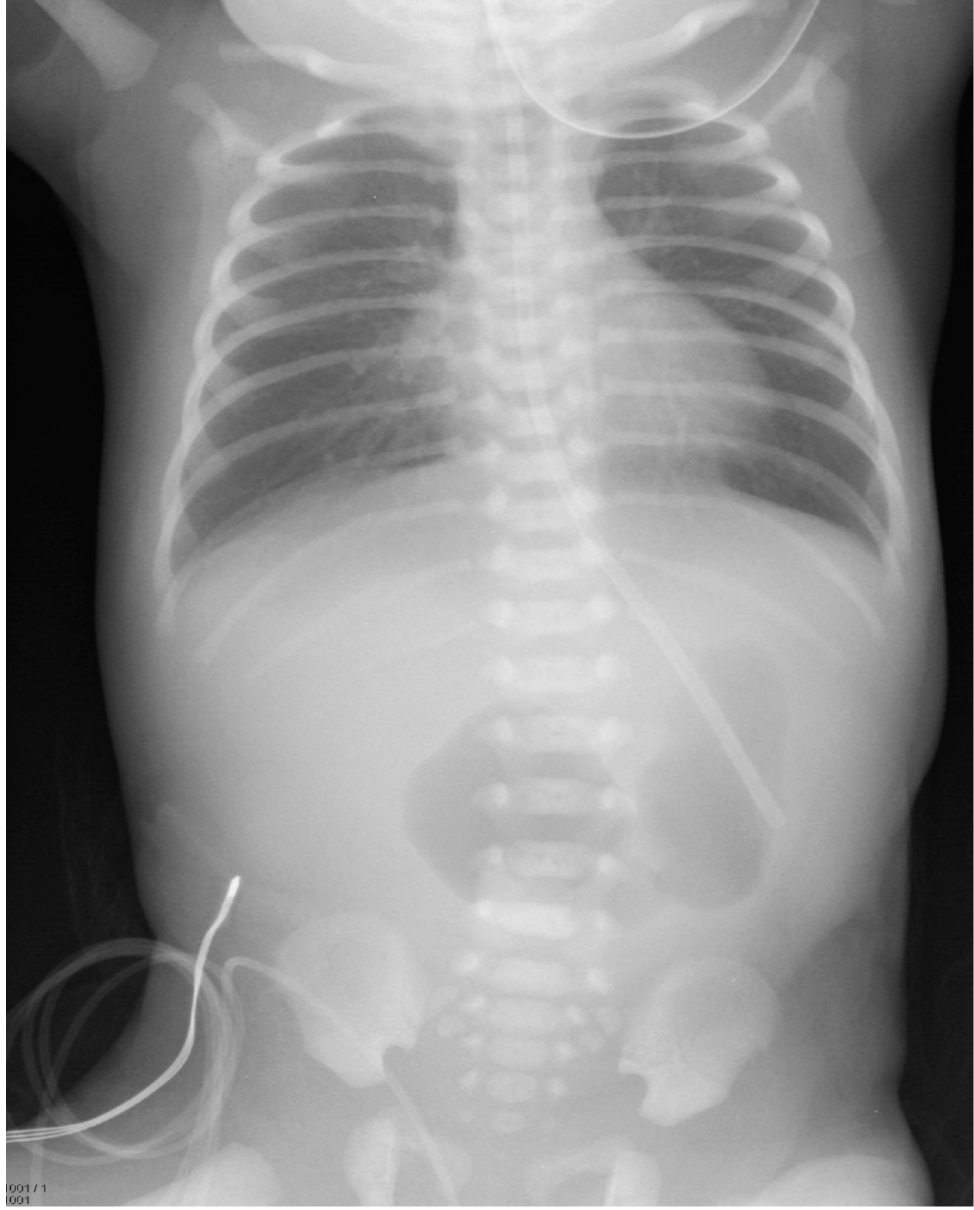
Figure 1. Plain abdominal radiograph taken soon after birth, showing a double-bubble in the lower abdomen.